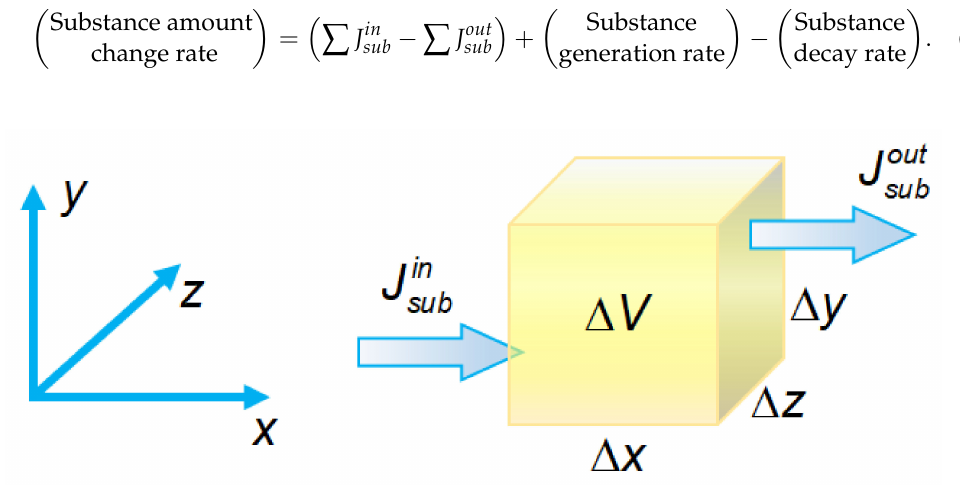
Figure 8. An elementary volume in three-dimensional space with incoming and outgoing fluxes of a